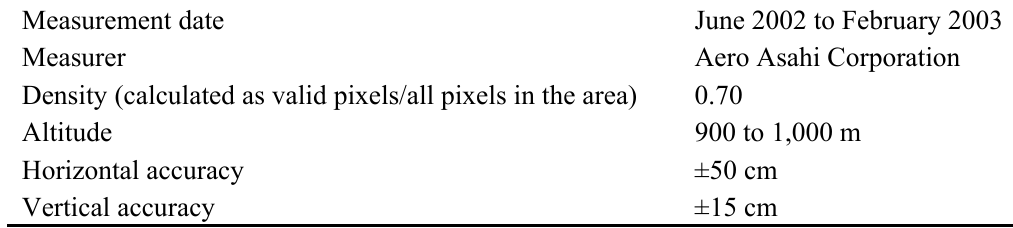
Table 2. Details of airborne light detection and ranging (LiDAR) used for this